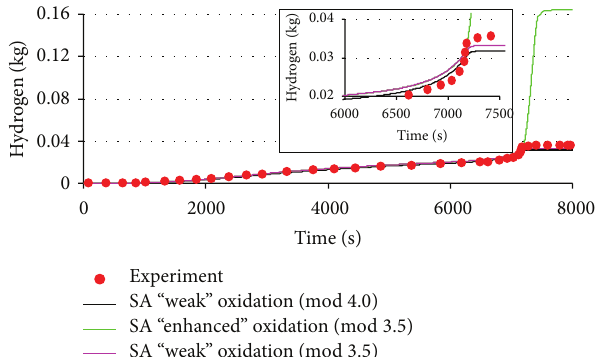
Figure 14: QUENCH-06 test calculation using RELAP/SCDAPSIM mod 4.0 and mod 3.5. Total hydrogen